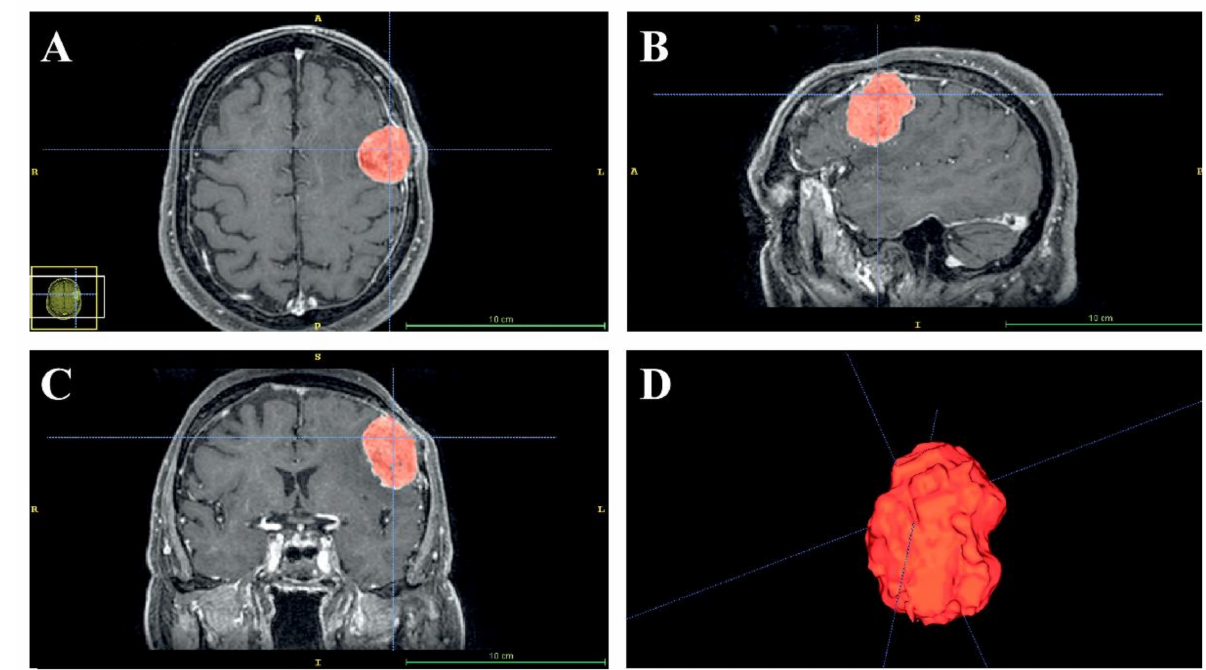
Figure 2. Semi-automatic segmentation of the preoperative axial ( A ), sagittal ( B ) and coronal ( C ) images using the EndoCAS Segmentation Pipeline. A 3D image reconstruction of tumors ( D